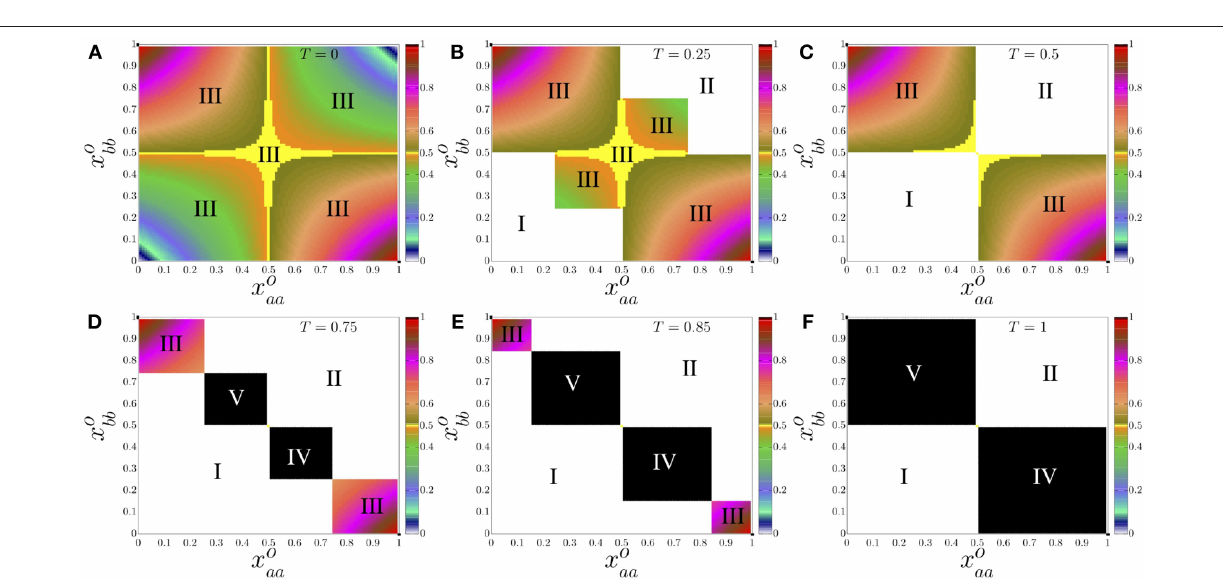
FIGURE 4 | Plot in color scale of the fraction of active links between layer A and B in the asymptotic solution of the dynamics as a function of the initial density of x aa and x bb for the Symmetric Coordination Game ( s = 0, b = 0). The color scale defines the values of the fraction of actives links, n AB = 1 black color and n AB = 0 white color. Asymptotic solutions are as indicated. (A–F) Correspond to different values of T : (A) T = 0, (B) T = 0.25, (C) T = 0.5, (D) T = 0.75, (E) T = 0.85, and (F) T = 1. System size, N A + N B = 1000 + 1000 =